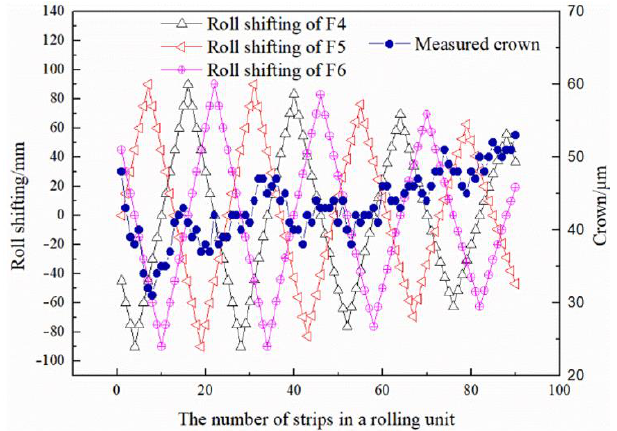
Figure 16. The double attenuation asynchronous roll shifting strategy and measured strip crown.